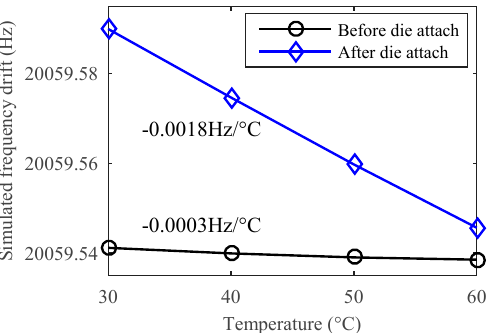
Figure 7. The simulated temperature drift of a single resonator’s natural frequency dominated by the thermal stress in design B. Sensors 2019 , 19 , x FOR PEER REVIEW